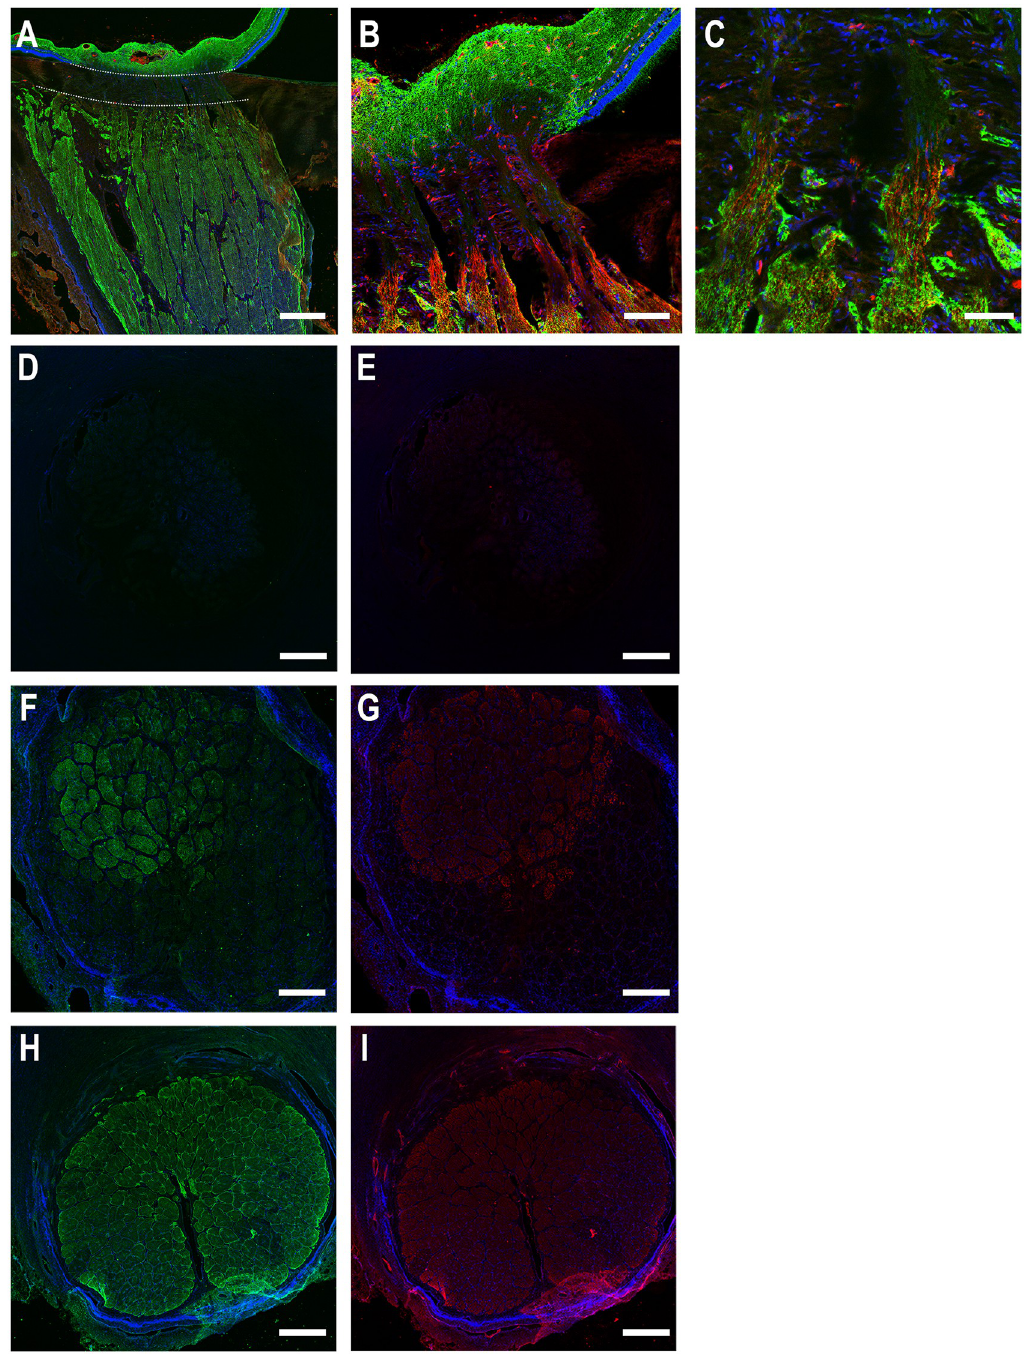
Fig 3. Longitudinal (A-C) and cross-sections (D-I) of porcine optic nerve head labeled for aquaporin 4 (AQP4, green), myelin basic protein (MBP, red) and DAPI (blue). In longitudinal section, A, the lamina cribrosa is indicated by the zone between dotted white lines. Label for AQP4 is present in the retina and prelaminar region, absent in the lamina, and begins again coincident with the initial zone of MBP labeling. The lamina cribrosa in cross-section (D,E) is devoid of both AQP4 and MBP. In F and G, the section has lamina in the inferior area and the initial myelinated optic nerve present in the upper portion, showing that MBP staining begins just anterior to that of AQP4. The myelinated optic nerve (H, I) labels for both AQP4 and MBP. Scale Bar: 200 μ m (A, D, E, F, G, H, I), 50 μ m (B), 25 μ m (C).